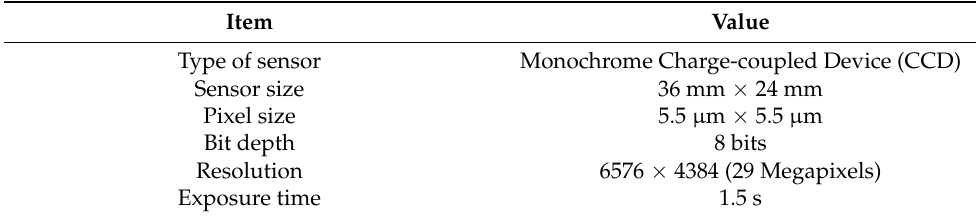
Table 2. Hardware properties of monitoring